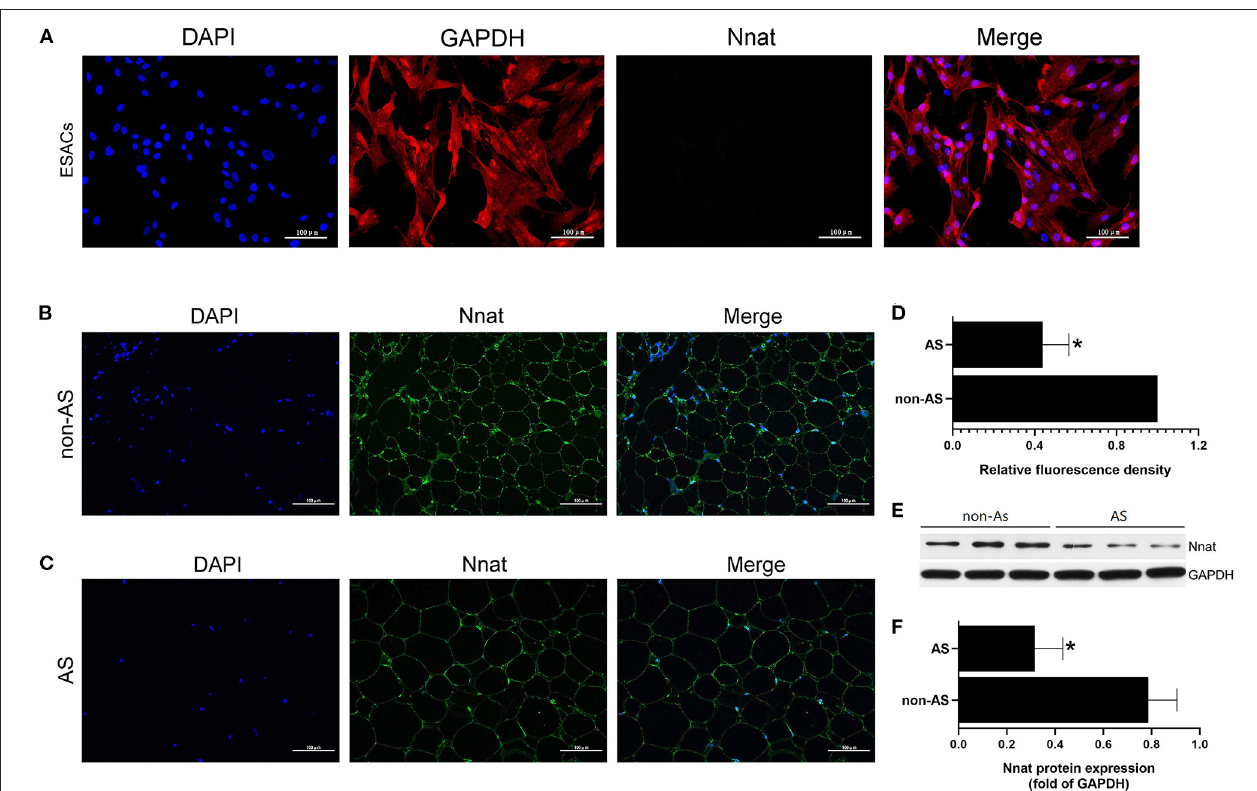
FIGURE 8 | The protein expression level of Nnat in EASCs and EAT. (A) Immunofluorescence staining of Nnat in EASCs climbing slices. (B) Immunofluorescence staining of Nnat in EAT of non-CAHD patients. (C) Immunofluorescence staining of Nnat in EAT of CAHD patients. (D) Relative fluorescence density analysis of Nnat in EAT of CAHD and non-CAHD patients. (E) The representative western blotting bands of Nnat in EAT of CAHD and non-CAHD patients. (F) Semi quantitative analysis of western blotting in (E) . non-AS: the EAT of non-CAHD patients. AS: the EAT of CAHD patients. Data are presented as the means ± standard error of the mean for six independent experiments. * P < 0.05 vs.